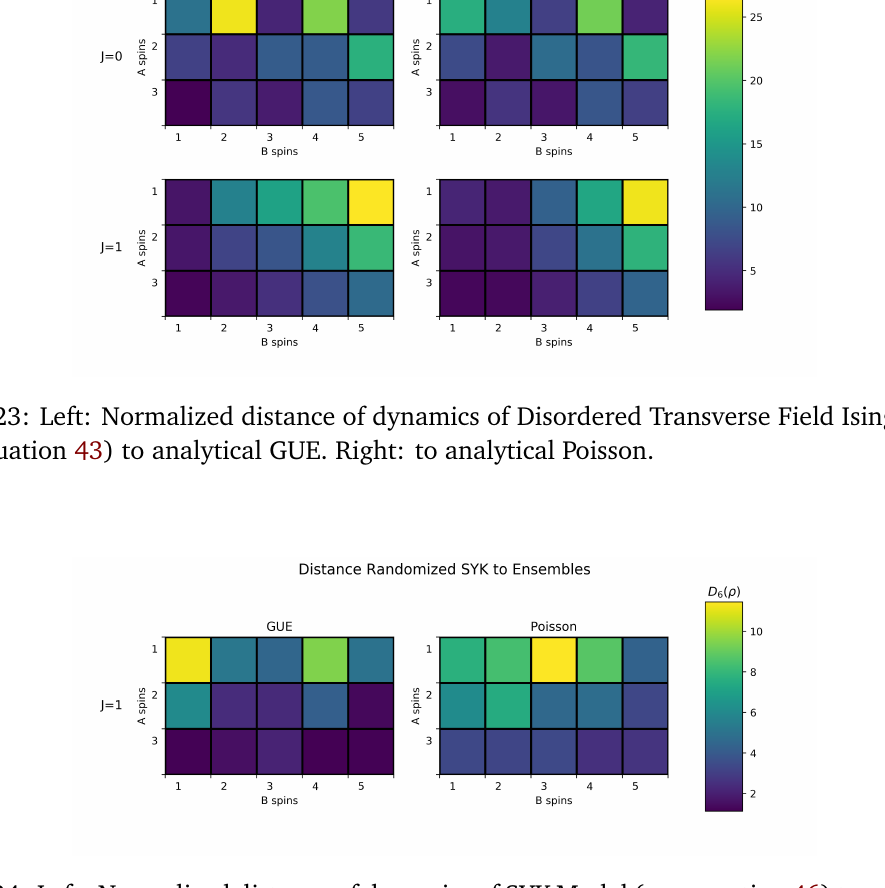
Figure 24: Left: Normalized distance of dynamics of SYK Model (see equation 46) to analytical GUE. Right: to analytical